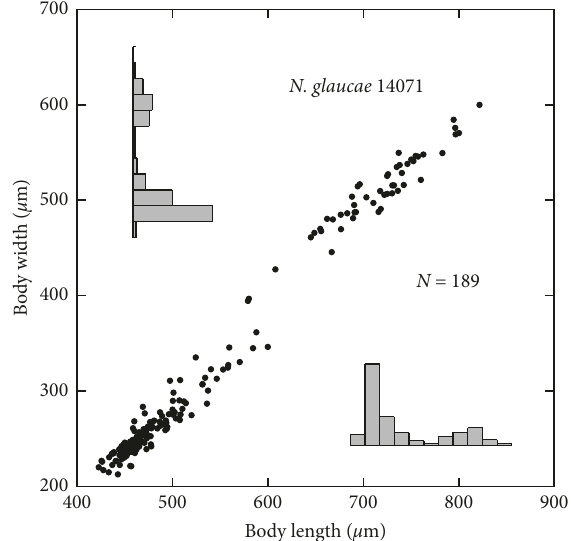
Figure 7: Scatter diagram of body length versus body width for apterous adults of Neothoracaphis glaucae (sample #14071), with frequency distribution diagrams of the body lengths and widths (40 μ m for 1 unit of the axis).